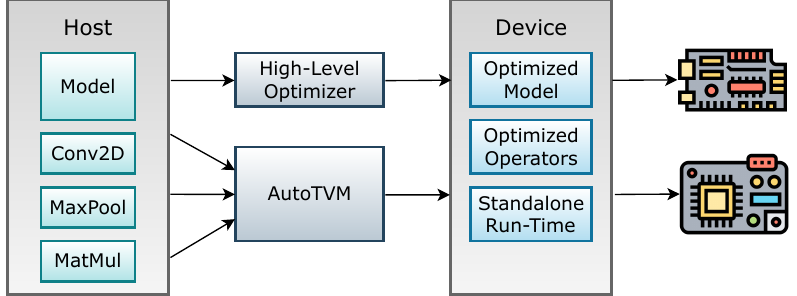
Figure 4. µ TVM optimization and application on a microcontroller system